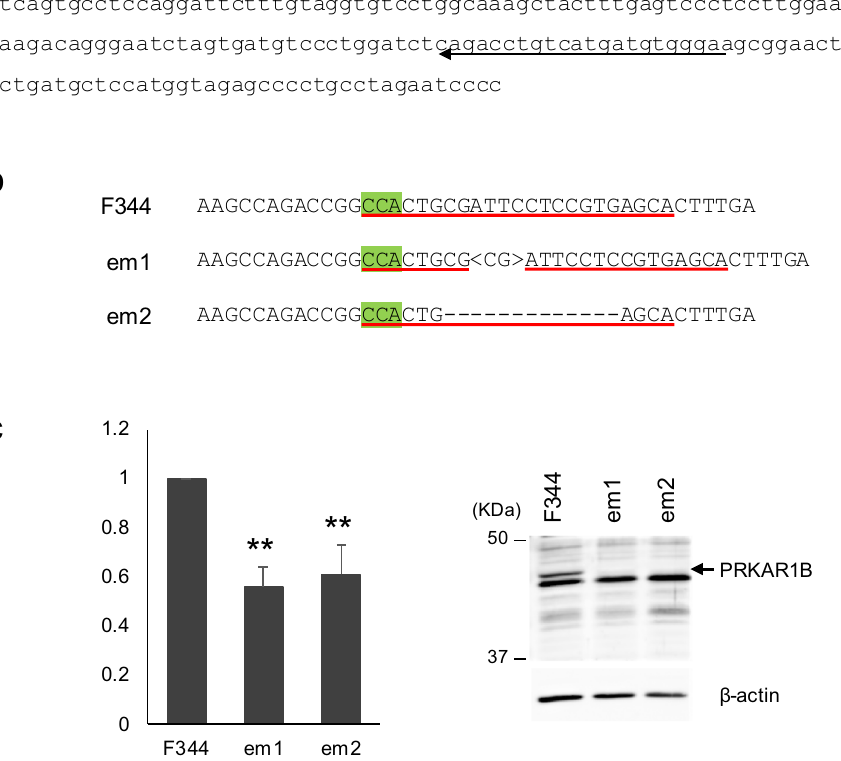
Figure 2. Development of Prkar1 -deficient rats. ( a ) Target sequence of guide RNA in the CRISPR/Cas system. Exon 2 and intron 2 of the rat Prkar1b gene are represented in upper- and lowercase, respectively. The coding sequence is represented in bold. The target sequence of the guide RNA is underlined and the PAM sequence is highlighted in green. Primer sequences to detect mutations induced by the CRISPR/Cas system are indicated by horizontal arrows. ( b ) Genomic alternations induced by the CRISPR/Cas system. A 2-bp insertion was found in the target site of the Prkar1b em1 line. A 13-bp deletion was found in the target site of the Prkar1b em2 line. ( c ) Relative expression level of the Prkar1b transcript (left) and expression level of PRKAR1B protein (right) in the hippocampus of Prkar1b -deficient rats. Expression levels of Prkar1b transcripts are significantly decreased in mutant lines. PRKAR1B proteins are diminished in mutant lines. ** P <